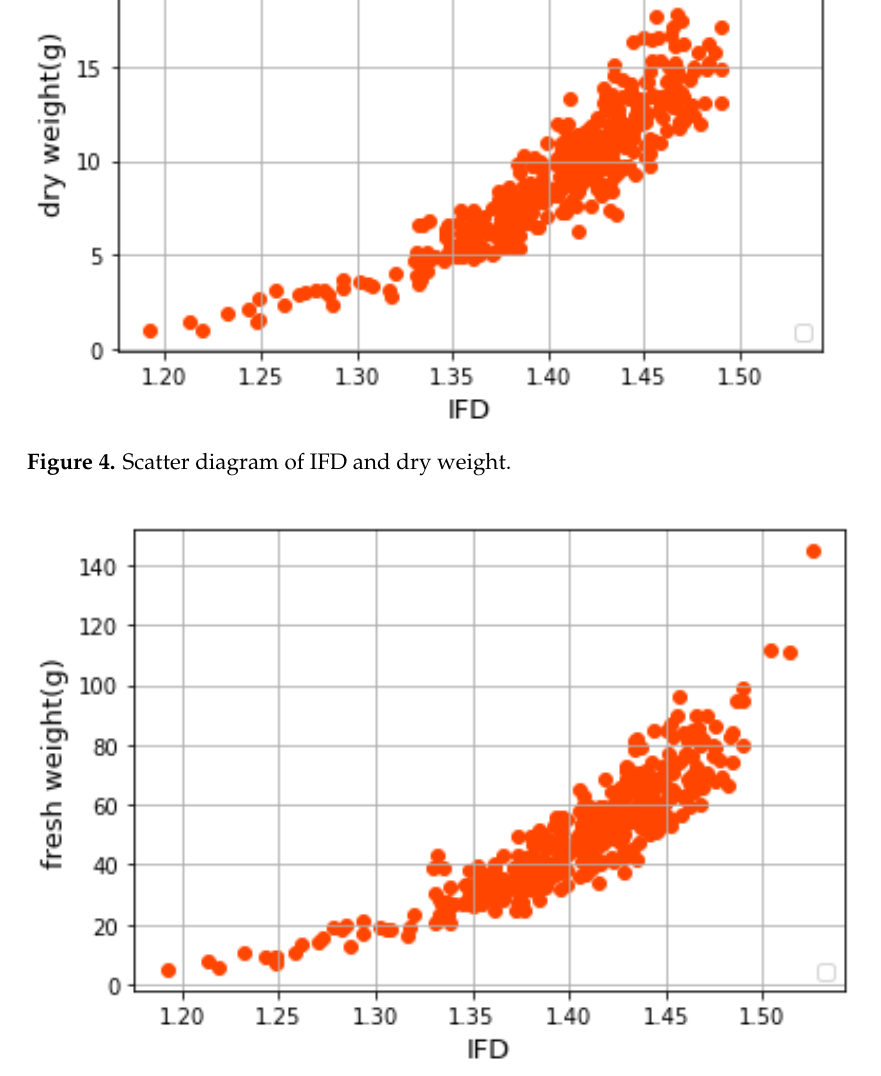
Figure 5. Scatter diagram of IFD and fresh weight. Table 2. Correlation coefficient between characterization and fresh weight of